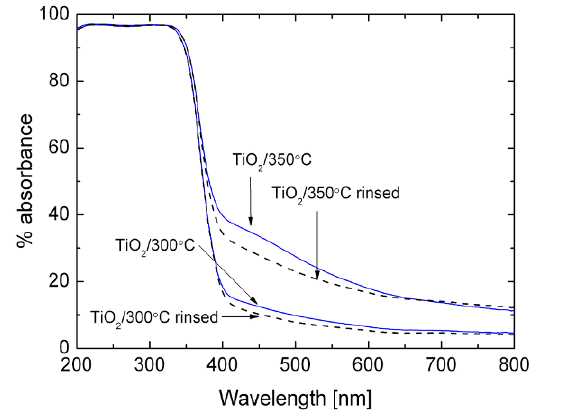
Figure 1. XRD patterns of the studied samples: [TiO [TiO /300ºC] and [TiO /350ºC]. 2 2